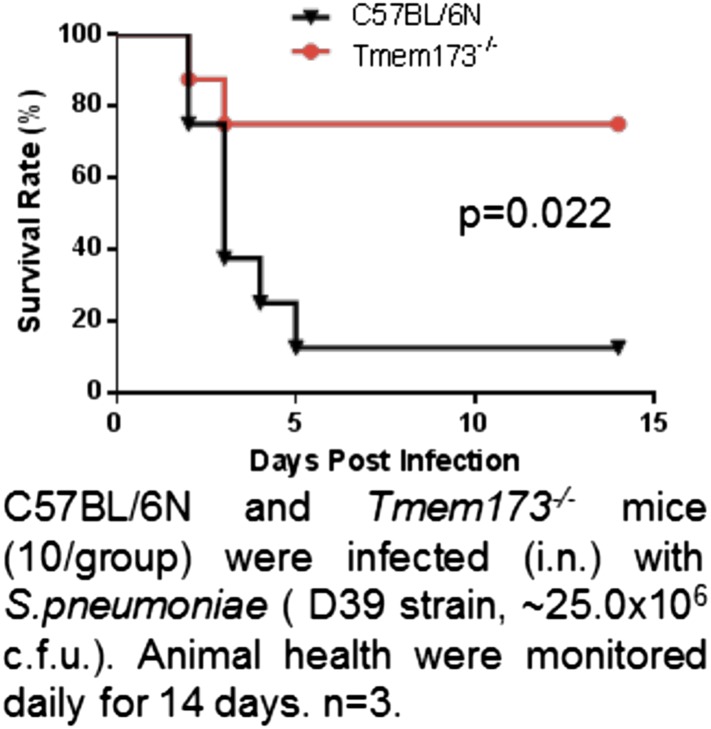
DOI:
http://dx.doi.org/10.7554/eLife.06670.018